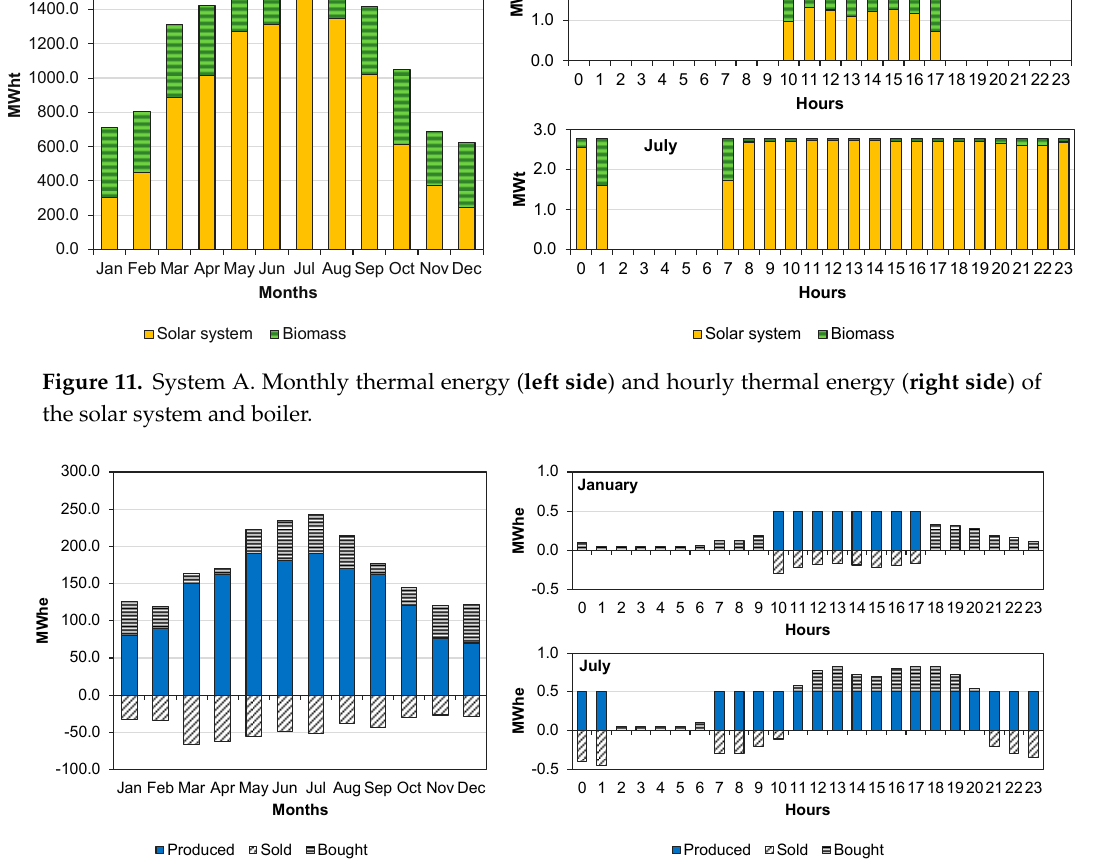
Figure 11. System A. Monthly thermal energy (left side) and hourly thermal energy (right side) of the solar system and boiler.